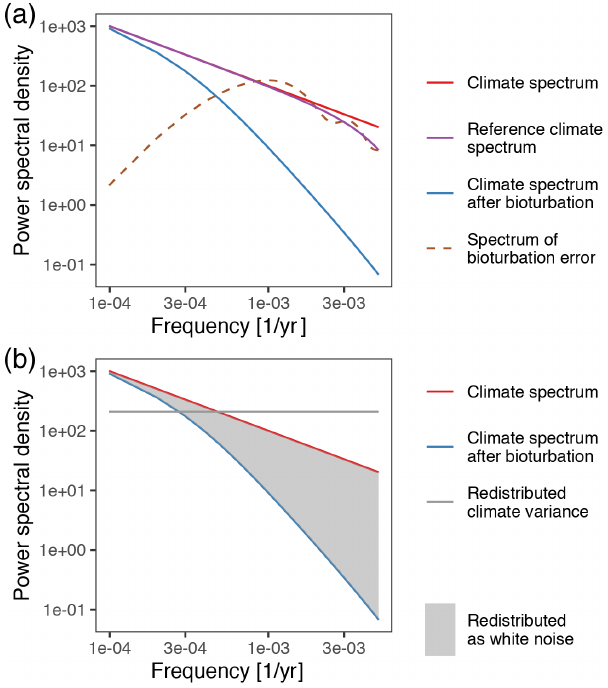
Figure 3. A conceptual representation of PSEM. (a) The true cli- mate signal is filtered (smoothed) by processes such as bioturba- tion. This modifies the power spectrum of the climate (red) in a frequency-dependent way, producing the power spectrum of the cli- mate signal after bioturbation (blue). Proxy records are assumed to represent the climate at a particular timescale (e.g., centennial, mil- lennial), and the reference climate spectrum (purple) is the power spectrum of the true climate smoothed to this timescale. The error that bioturbation and other smoothing produces (dashed brown) is a function of the reference and bioturbated climate spectra. (b) The power of the true climate signal that is removed by bioturbation and other smoothing processes (gray shaded region) can be redis- tributed as a white noise error component (gray horizontal line) if the time period over which individual signal carriers are created (e.g., foraminiferal tests calcify) is short relative to the timescale of the smoothing processes. This white noise term is reduced if multi- ple signal carriers are measured together or if their values are aver- aged together